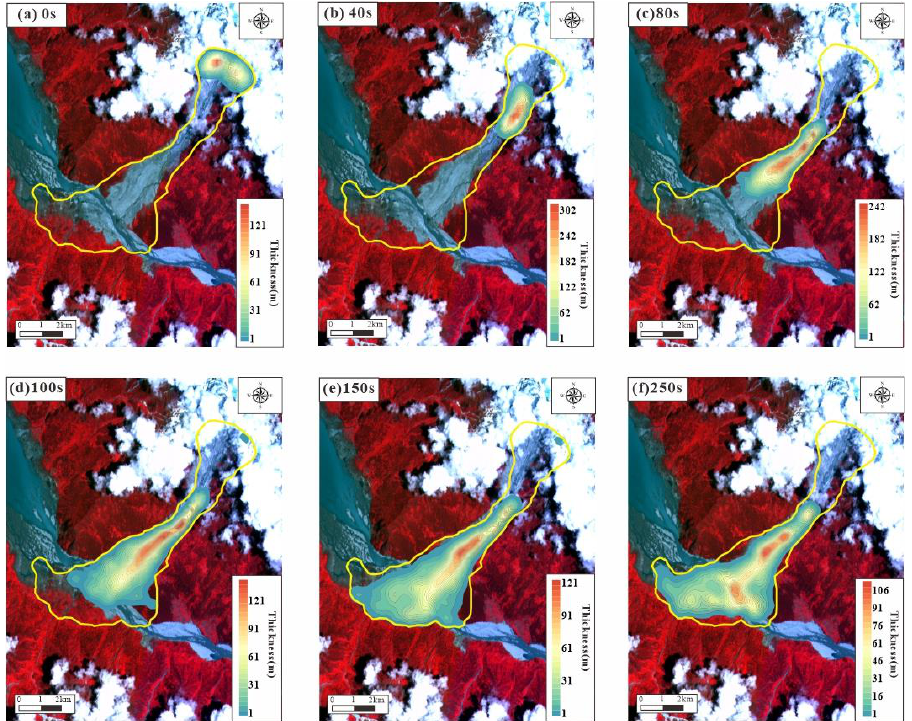
Figure 10. Contour map of the simulation process under extreme simulation condition. ( a – f ) show six typical contour maps selected from the simulation process of 0 s – 250 s. The yellow line repre- six typical contour maps selected from the simulation process of 0 s–250 s. The yellow line represents sents the maximum range of landslide in the simulation process. the maximum range of landslide in the simulation